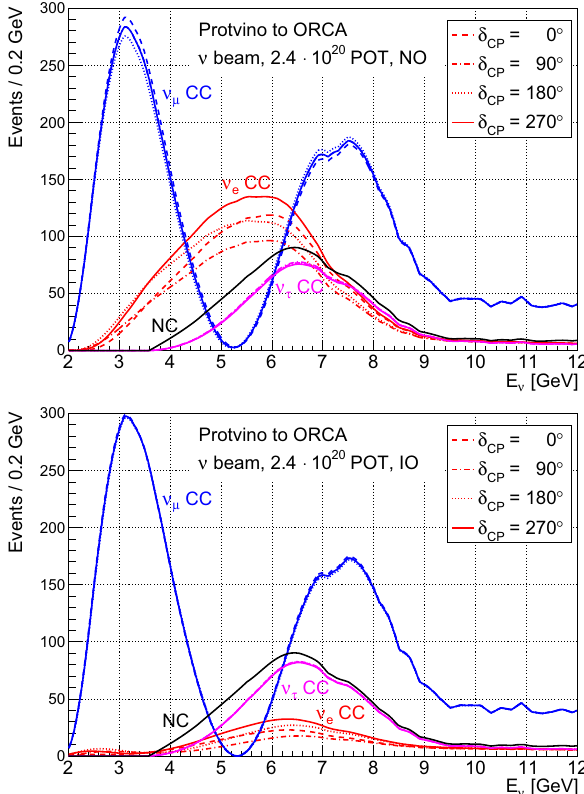
Fig. 7 Energy distribution of the expected number of neutrino events that would be detected by ORCA after 3 years of running with a 90 kW beam from Protvino (neutrino mode) for 4 different values of the CP phase for the case of normal (top plot) and inverted (bottom plot) neutrino mass ordering. θ 23 = 45 ◦ is assumed. The x axis shows the true neutrino